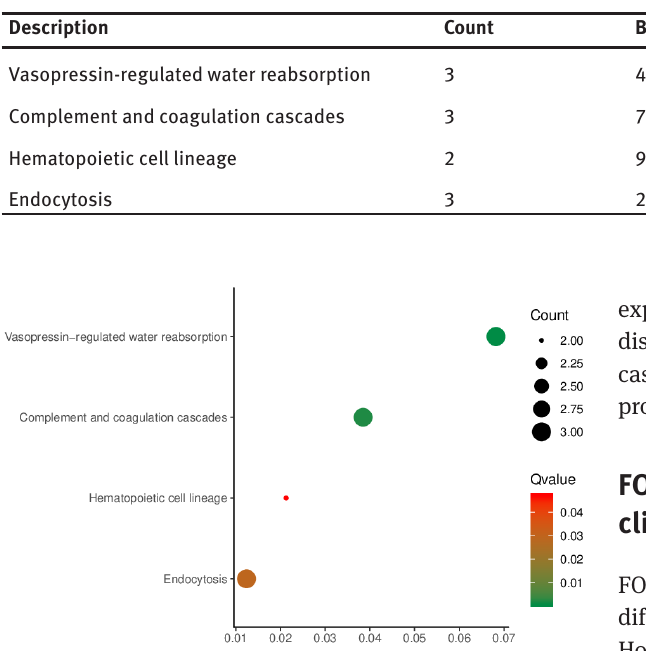
Table 3: KEGG pathway enrichment of FOLR1 and relevant genes in the aspects of BP, CC and MF.